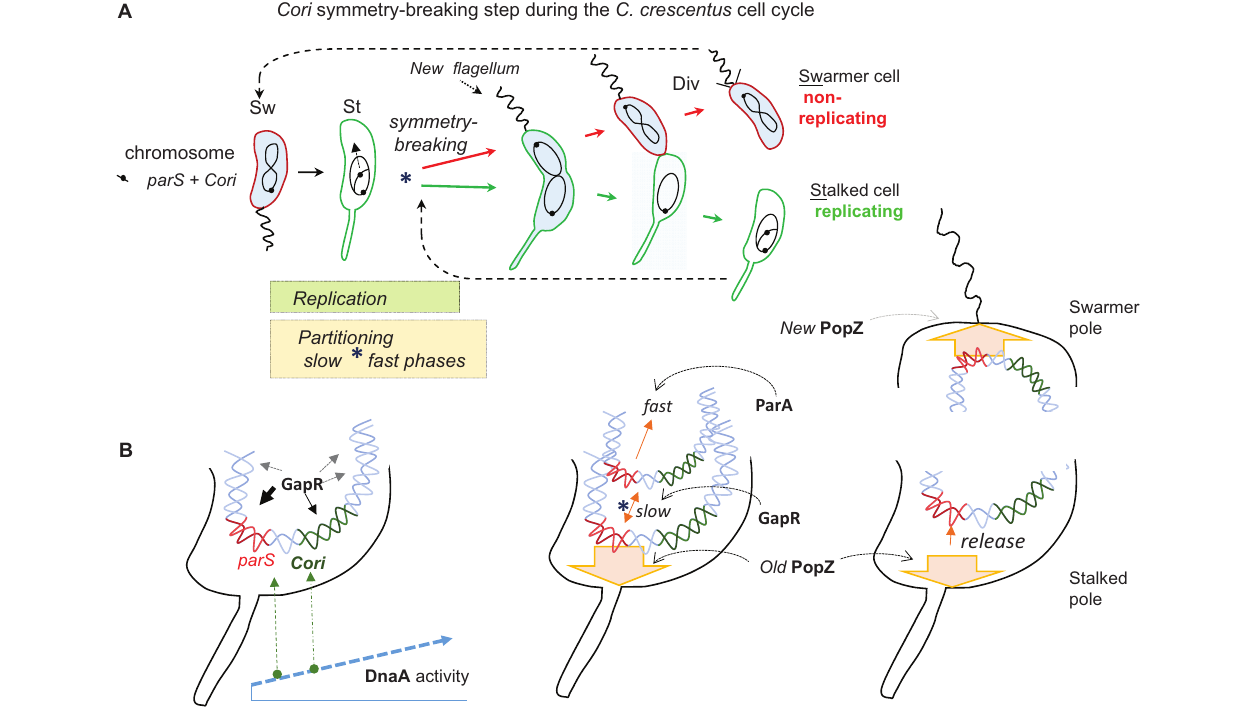
FIGURE 1 | The C. crescentus cell cycle emphasizing asymmetric chromosome replication and partitioning. (A) The cell cycle conceptually starts on the left with the swarmer cell (Sw). It has one circular chromosome that is held at the flagellated cell pole by the centromere-like ( parS ) DNA linked to the origin of replication ( Cori ). The swarmer cell next differentiates into a non-motile and replicating stalked cell (St). Coincident with this cell differentiation, the chromosome replication and partitioning phases initiate apparently simultaneously, and they continue together for much of the cell cycle. The partitioning movement of parS-Cori has an initial slow phase that uses GapR protein and a later fast phase that requires the partitioning protein ParA (see text for further details). This slow partitioning phase overlaps the chromosome “symmetry breaking” step (*) of the cell cycle, which symmetrically channels the duplicated parS-Cori regions and eventually the entire chromosomes into distinct replicating (stalked cell) and non-replicating (swarmer cell) compartments. The blue cytoplasmic shading represents the activity (presence and phosphorylation) of the master cell-cycle regulator CtrA, which among many functions bind Cori to repress replication in swarmer cells. Asymmetric cell division (Div) proceeds with the return of CtrA activity and the building of a new polar flagellum. Eventually the two distinct cell types are formed. (B) A closer look at the cell poles during the above cell cycle. On the left, an early stalked cell pole where the parS-Cori region has been released from the PopZ matrix protein (not shown) and where rising DnaA activity first acts at parS DnaA boxes before acting at the Cori DnaA boxes. Although GapR binds broad regions of the chromosome, its strongest peaks are around the parS-Cori DNA. Next, a stalked cell pole immediately following the initiation of chromosome replication. One duplicated parS-Cori region reattaches to the old PopZ matrix at the stalked pole (symbolized by the broad arrow, the ParB bridge is not shown). The other duplicated parS-Cori region moves slowly away with the aid of GapR before its fast movement driven by ParA toward the other cell pole. On the right, both poles of a dividing cell. At the swarmer pole, the translocated parS-Cori region is attached to the new PopZ matrix that formed coincidentally with its arrival. At the opposite stalked pole, the parS-Cori region is released from PopZ roughly coincident with stalked cell reentry into another round of chromosome